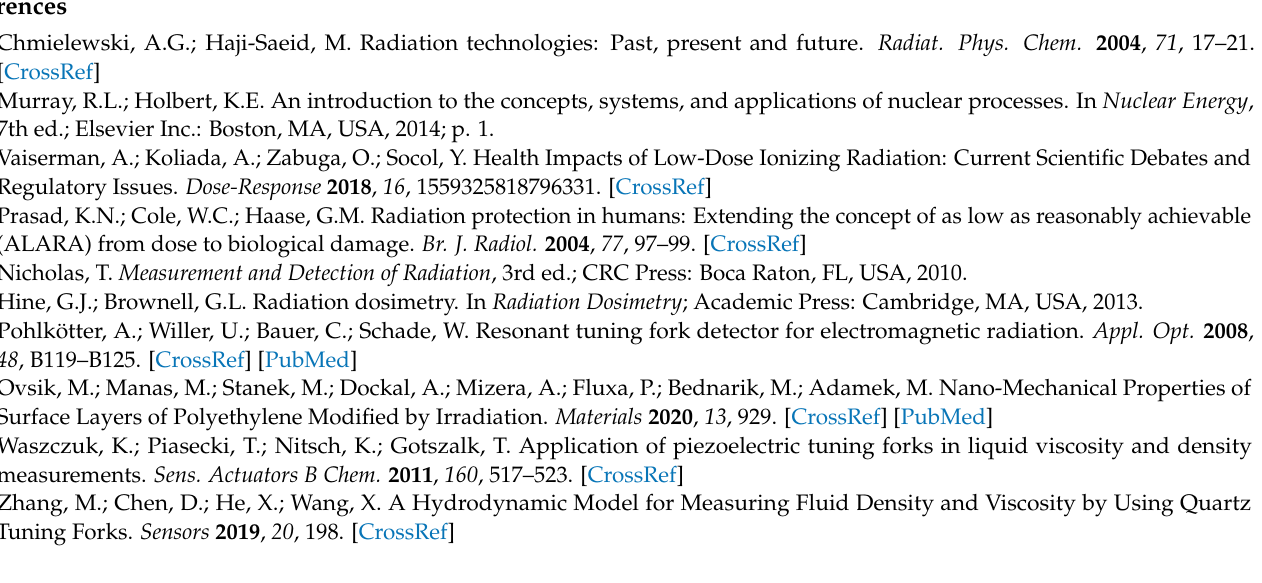
( µ Gy) level of gamma source , Figure S2: Residual Plots for QTFgl: resonance frequency vs time (hr), Dose ( µ Gy) level of gamma source, Figure S3: Residual Plots for QTFgl: resonance frequency vs time (hr), Dose ( µ Gy) level of gamma source, Figure S4: Response optimizer for time, dose level vs resonance frequency, Table S1: Design of Experiment with Main Variables, Table S2: Taguchi Experimental Design Test Matrix (L9) for Detection of gamma radiation as a function of dose and time duration, Table S3: ANOVA for resonance frequency response of QTFg vs time (hr), dose ( µ Gy) level, Table S4: ANOVA for resonance frequency response of QTFgl vs time (hr), dose ( µ Gy) level, Table S5: ANOVA for resonance frequency response of QTF vs time (hr), dose ( µ Gy)